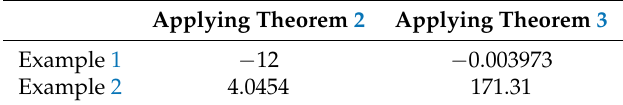
Table 2. Objective function values using Theorems 2 and 3.